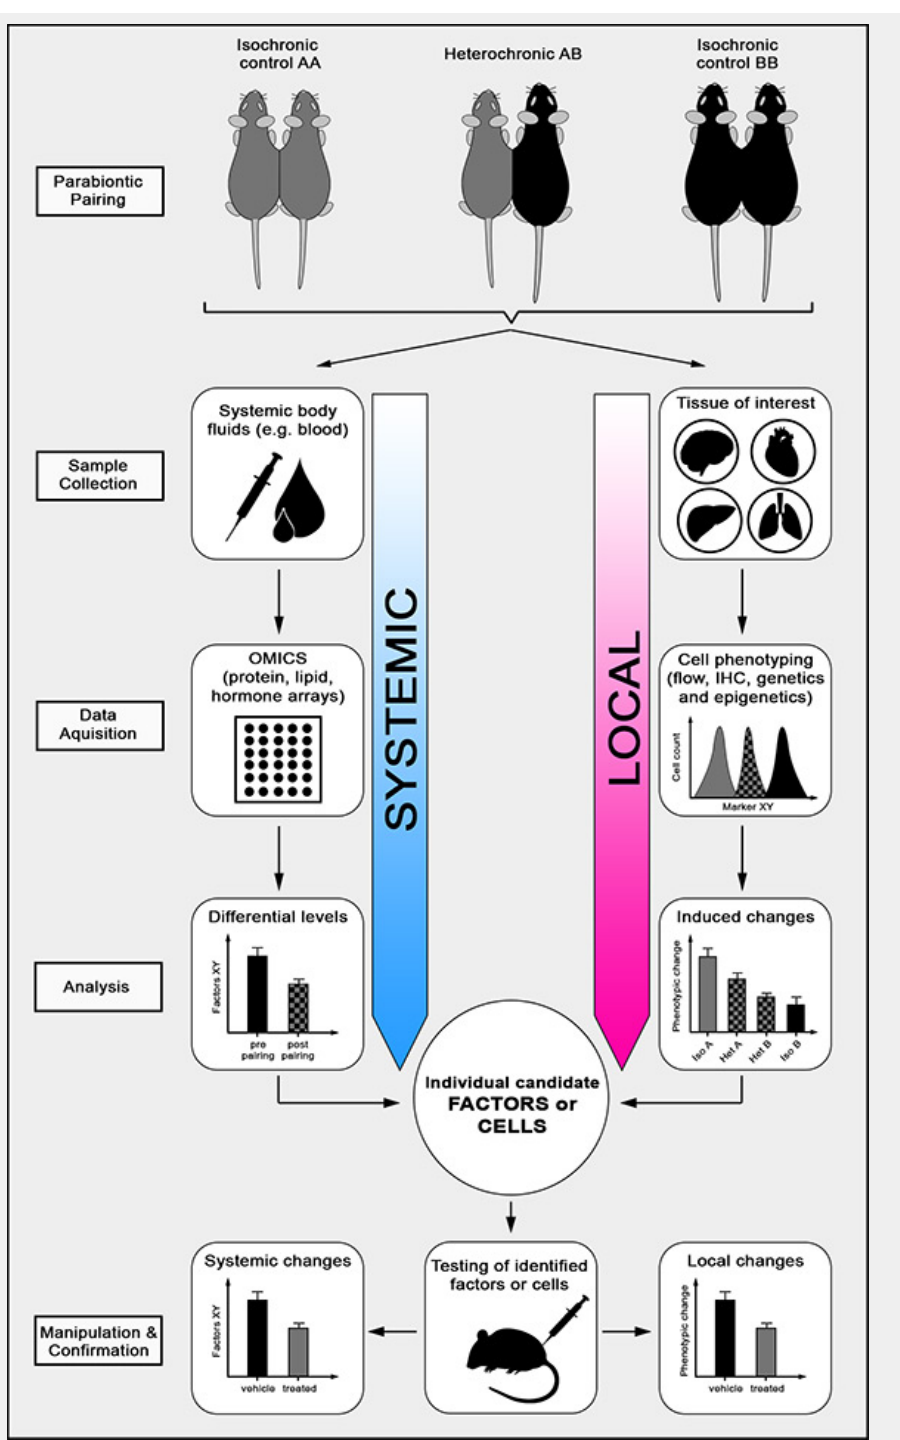
Figure 3 Heterochronic parabiosis. Using heterochronic pairings of young (A) and old (B) mice allows assessment of the effect of a young systemic environment on a particular local tissue of interest in the aged partner and vice versa. Isochronic pairings (AA or BB) are important controls to exclude surgery-related observations and to determine age-related changes in the systemic environment. Briefly, systemic body fluids such as blood, lymph or cerebrospinal fluid are collected, assessed with omics tools such as protein, lipid or hormone arrays and analysed for differential levels of soluble factors after and after parabiosis. A particular tissue of interest is isolated, phenotypically characterised by flow cytometry, immunohistochemistry (IHC) or epi-/genetic measures and analysed for parabiosis-induced phenotypic changes. The integration of these data leads to the identification of individual candidate factors or cells that can subsequently be tested in a suitable mouse